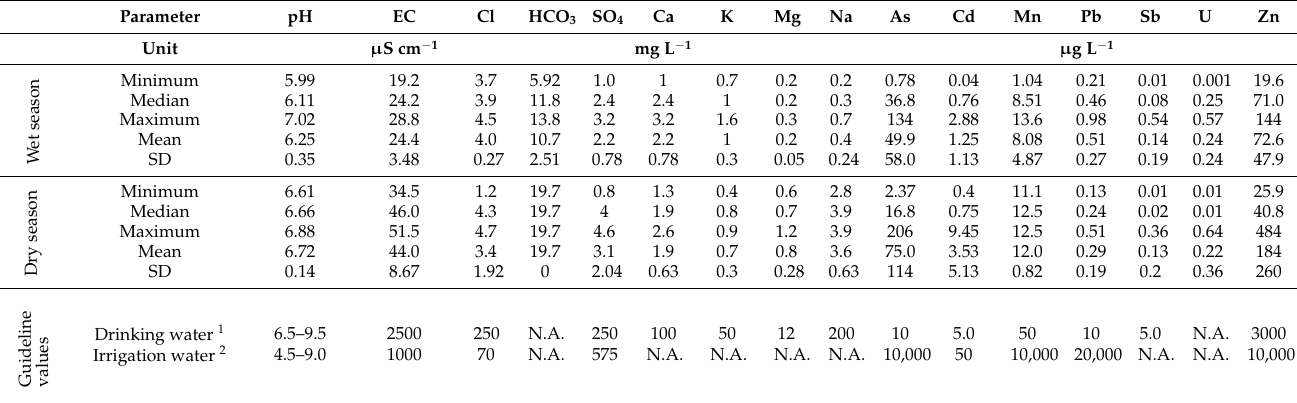
Table 4. Descriptive statistical summary of the analysed physicochemical parameters and chemical concentrations of selected ions/elements from surface waters collected in the Regoufe area ( n = 7 (wet season) and n = 3 (dry season)). Parameter pH EC HCO 3 SO 4